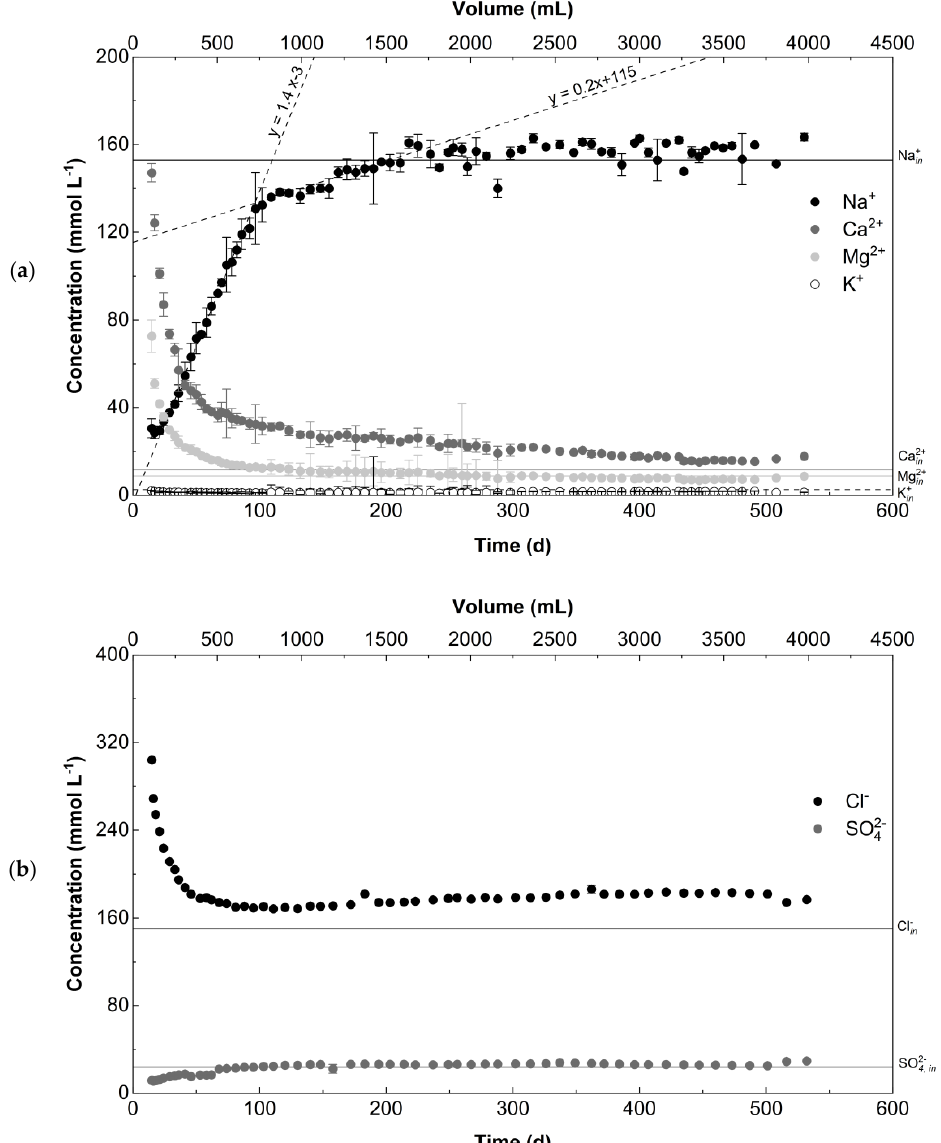
Figure 4. Cation concentration ( a ) and anion concentration in outflow ( b ) of cell 9.